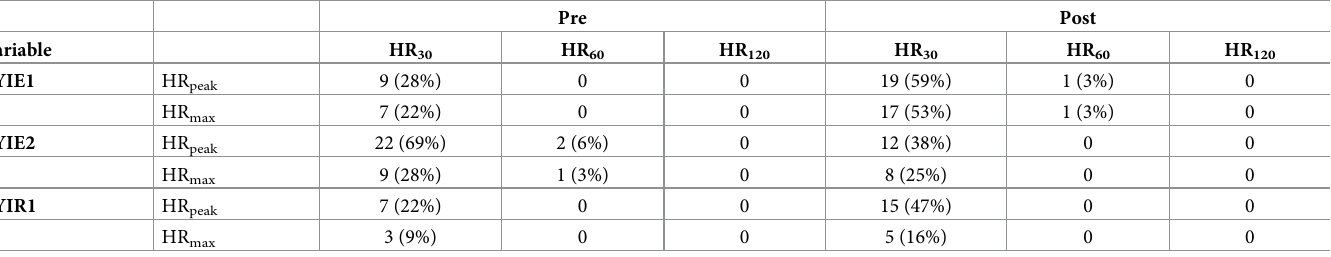
Table 5. Frequency (count and %) of participants with heart rate (HR) recovery difference � 12 beats � min -1 in the untrained and trained state (i.e., at pre- and post- intervention).